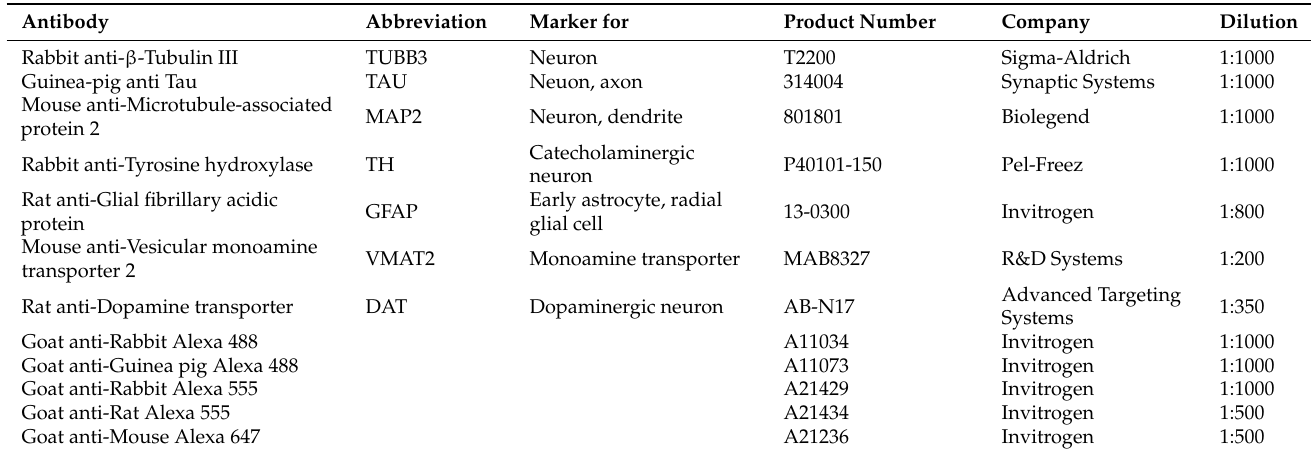
Table 2. Primary and secondary